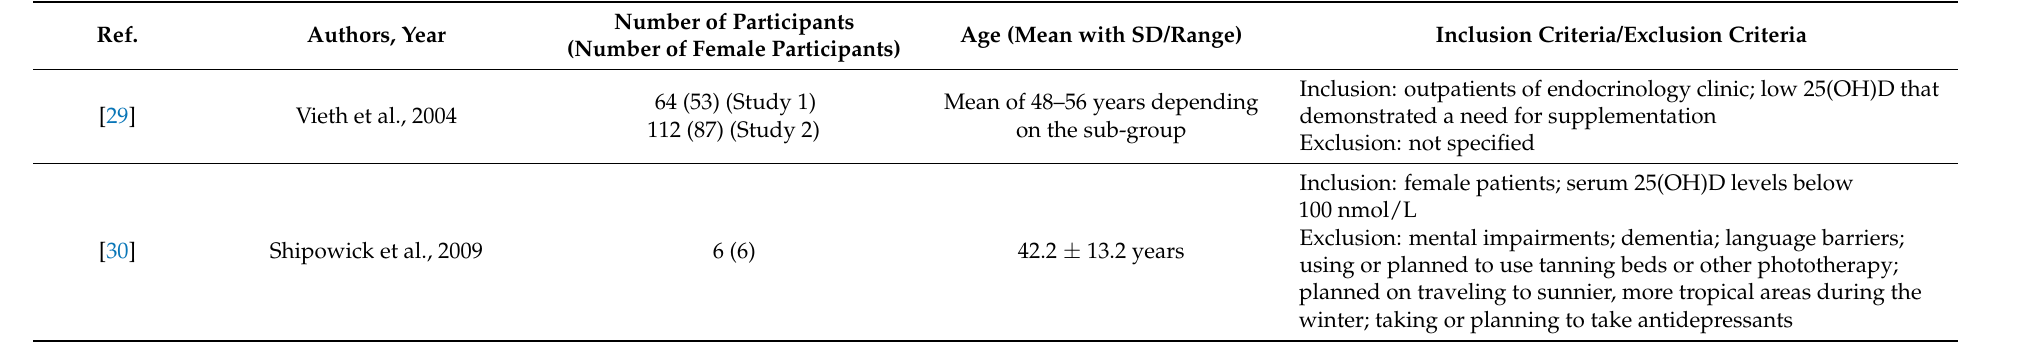
Table 3. The characteristics of the groups studied within the studies included in the systematic review.